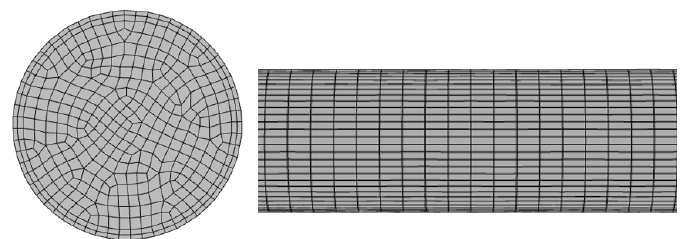
Figure 5. Computational mesh for the undeformed tube in the transverse and the longitudinal directions. (Only a short section of the longitudinal mesh is displayed).